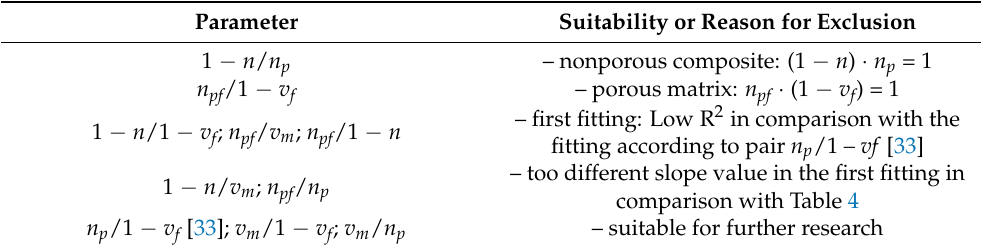
Table 3. Suitability of all possible 10 structural parameter pairs for research. Unsuitable pairs were excluded immediately after finding some insufficiency without searching for their complex